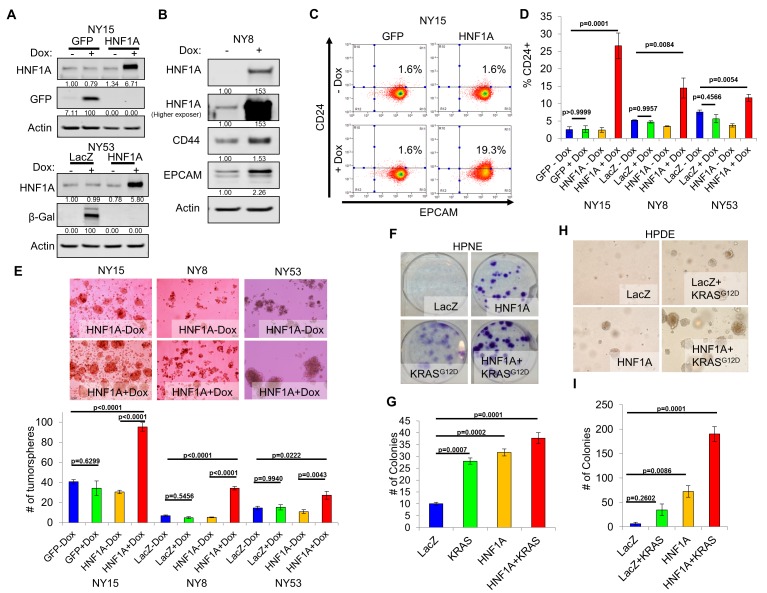
Overexpression of HNF1A promotes CSC properties in PDA cells and normal pancreatic cell lines.(A) NY15 and NY53 cells Western blotted for HNF1A and control gene induction following 48 hr ± doxycycline (Dox). Quantitation of proteins is indicated below the respective blots. (B) NY8 cells were treated 48 hr ± Dox to induce ectopic HNF1A. Lysates were western blotted for HNF1A, Actin, and PCSC markers EPCAM and CD44. Quantitation of proteins is indicated below the respective blots. (C) Representative surface expression of CD24 and EPCAM on NY15 cells expressing GFP or HNF1A. (D) Quantitation of CD24 +NY15 GFP and HNF1A cells and NY8 and NY53 LacZ and HNF1A cells by flow cytometry (n = 3). Statistical difference was determined by one-way ANOVA with Tukey’s multiple comparisons test. (E) NY15 GFP and HNF1A, NY8 and NY53 LacZ and HNF1A cells were grown under sphere-forming conditions ± Dox. The number of tumorspheres formed after 7 days were quantitated (n = 4). Statistical difference was determined by one-way ANOVA with Tukey’s multiple comparisons test. Representative images (100X magnification) of spheres are shown in the upper panels. (F, G) HPNE LacZ and HNF1A cells were plated at 200 cells/6 cm dish and treated ±Dox for 2 weeks, fixed, and stained with crystal violet (F). (G) Resultant colonies were quantitated (n = 3). Statistical difference was determined by one-way ANOVA with Dunnett’s multiple comparisons test. (H, I) HPDE cells expressing inducible LacZ, LacZ with KRASG12D, HNF1A, or HNF1A with KRASG12D were embedded in soft agar + Dox and monitored for signs of anchorage-independent growth for 21 days. (H) Representative images of resultant colonies (100X magnification) and (I) quantitation of colonies after 21 days (n = 3). Statistical difference was determined by one-way ANOVA with Dunnett’s multiple comparisons test. Related data can be found in Figure 4—figure supplement 1.10.7554/eLife.33947.017Figure 4—source data 1.Quantitation of CD24 expression and tumorsphere formation in PDA cells with HNF1A overexpression, and quantitation of colony formation in HPNE and HPDE cells expressing HNF1A and oncogenic KRAS.10.7554/eLife.33947.018Figure 4—source data 2.Quantitation of CD44+/CD24+ HPDE and HPNE cells overexpressing HNF1A.